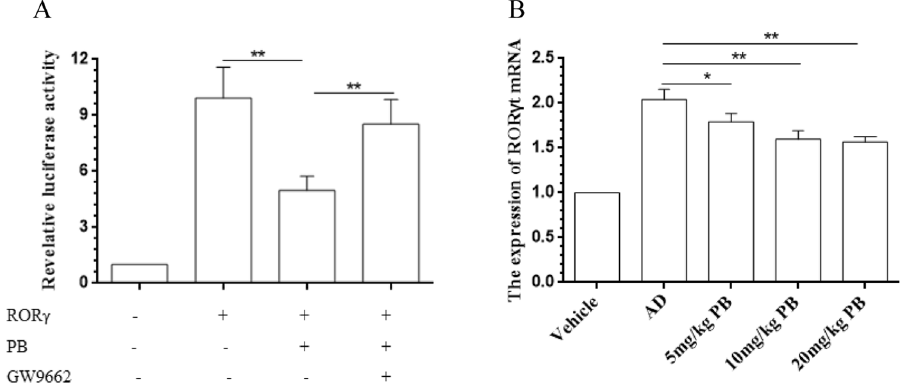
Figure 8. Inhibition of PB on ROR γ -mediated Il17 promoter activation. ( A ) Human T cell derived Jurkat cells were obtained from ATCC, and maintained in RPMI-1640 medium containing 10% FBS and antibiotics, which were co-transfected with pCMV- β -Gal, pCMV10-3xFlag-ROR γ and pGL4.14 reporter plasmid under the control of Il17 promoter and treated with PB at 0.5 μ mol/l or pre-incubated with GW9662 (1.0 μ mol/l) 1 h before added with PB. After 24 h, relative luciferase activity was determined and normalized against β -galactocidase activity. Data are presented as mean ± SD. Each measurement was performed in duplicate and all experiments were repeated three times. ** P < 0.01. ( B ) Total RNA from the draining lymph nodes of NC/Nga mice was extracted and reverse transcribed into cDNA. The mRNA expression of ROR γ t was measured by qRT-PCR. Data are representative of two independent experiments and presented as mean ± SD of n = 8 mice per group. * p < 0.05, ** p < 0.01. Vehicle, intact mice with saline treatment; AD, DNFB-sensitized and challenged mice; PB, pseudolaric acid B.